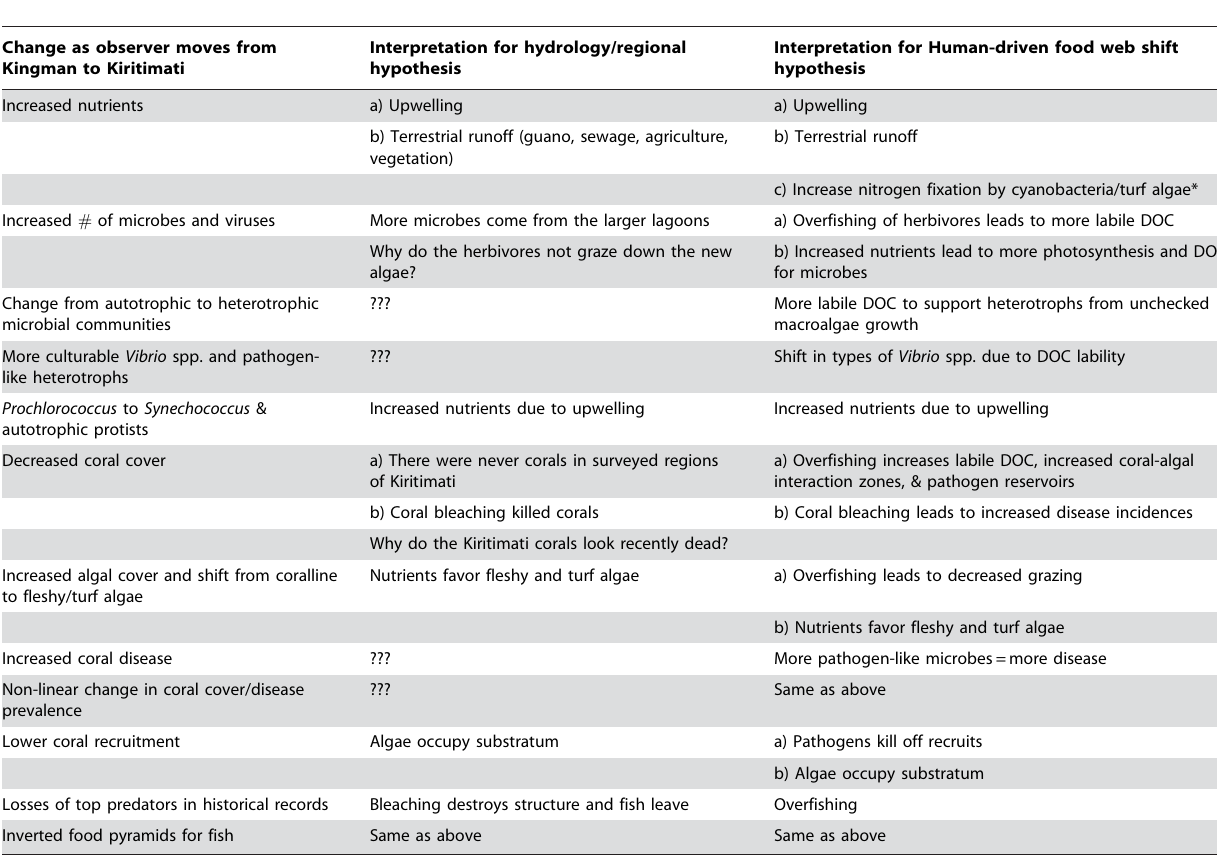
Table 1. Summary of observations and possible interpretations of microbial and macro-organism data collected from the Northern Line Island